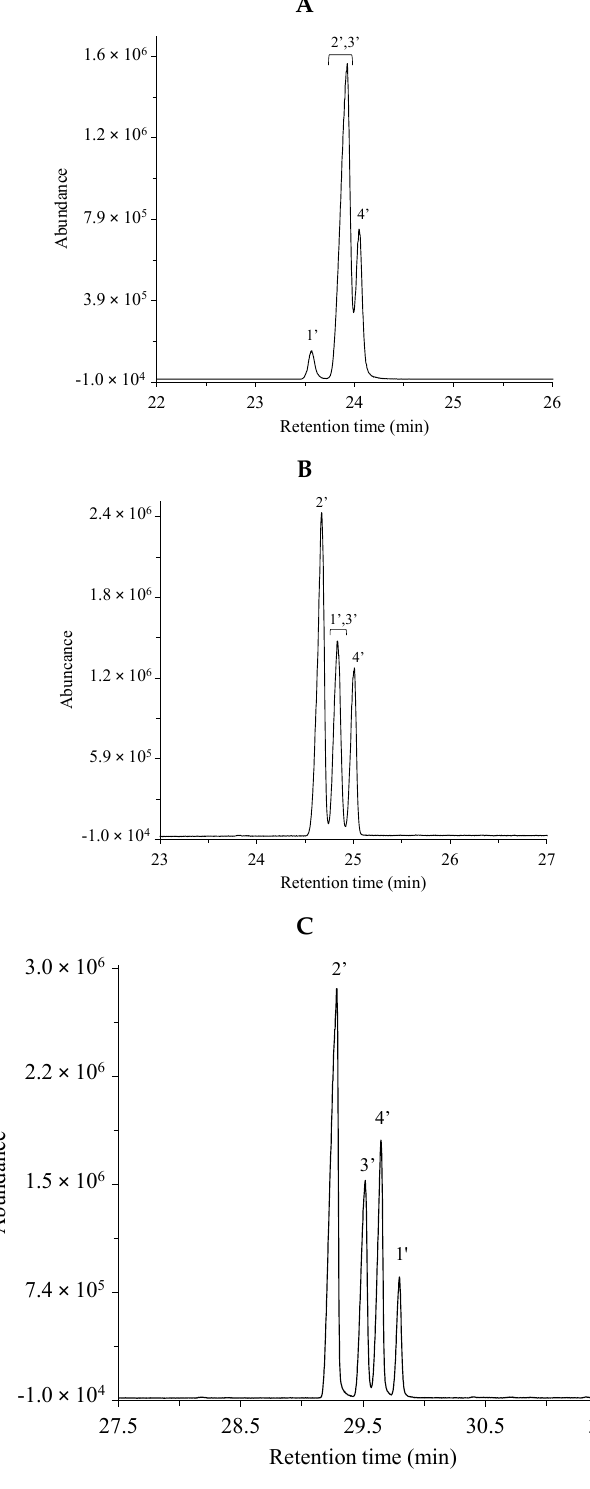
Figure 2. Total ion chromatograms of the CRM47741 fatty acid methyl ester mixture using the ( A ) non- polar HP-5MS column, ( B ) the medium/high polar DB-225MS column and ( C ) the extremely polar, ionic liquid-based SLB-IL111 column. The peak labels indicate components listed in Table 2 according to the retention order in the separation with the HP-5MS column. The optimized experimental conditions are detailed in Materials and Methods. Total FAME concentration is 80.6 µ g mL − 1